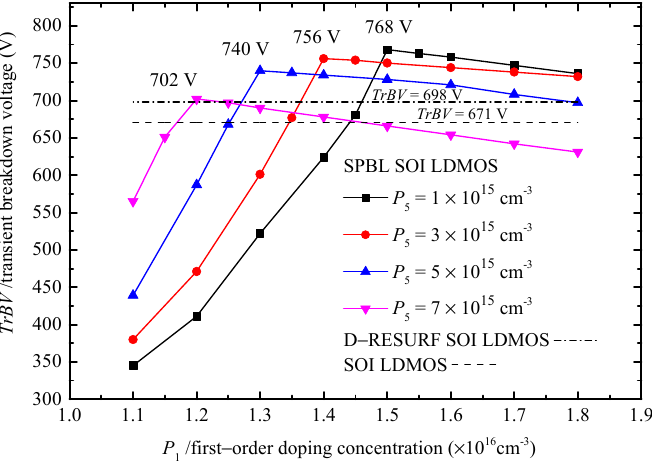
Figure 5. Effect of the SPBL doping concentration on the TrBV of the SPBL SOI LDMOS. Figure 6 shows the influence of the number of doping regions ( N ) of SPBL on TrBV and surface electric field. The TrBV of the SPBL SOI LDMOS listed in Figure 6a was the maximum value that could be gained by optimizing the doping concentration of SPBL at different N . The TrBV of the device increased with the N and then tended to be saturated. In Figure 6b, the surface electric fields of the SPBL SOI LDMOS were compared at different N . When N = 2, there was a comparatively high peak in the middle of the surface electric field, but the electric field near the drain was too low. TrBV was 614 V. When N = 3, there were two peaks in the middle of the surface electric field, which made the surface electric field more uniform and the electric field near the drain higher. TrBV increased to 696 V. When N = 4, the surface electric field in the middle of the drift region and near the drain was more uniform, and TrBV was further increased to 761 V. When N = 5, the surface electric field distribution was almost the same as that of N = 4, and TrBV was 768 V and only increases by 7 V. Therefore, with an increase of N , the SPBL modulated the surface electric field more uniformly, and a higher TrBV could be obtained. For the SOI LDMOS, the surface electric field at the source was too high at N d = 5 × 10 15 cm − 3 . The device was prematurely broken down, and its TrBV was 337 V. When N d = 2.4 × 10 15 cm − 3 , the surface electric field peaks were at the source and drain, and the electric field at the middle of the drift region was low. TrBV was increased to 671 V. Compared to that of the SOI LDMOS, the surface electric field of the D-RESURF SOI LDMOS in the drift region was more uniform and higher, and its TrBV was also 27 V higher. The R on,sp of the SPBL SOI LDMOS was the lowest among those of the three devices. At N = 3, the TrBV of the SPBL SOI LDMOS was as high as that of the D-RESURF SOI LDMOS and higher than that of the SOI LDMOS. At N > 3, the TrBV of the SPBL SOI LDMOS was higher than that of the other two devices.